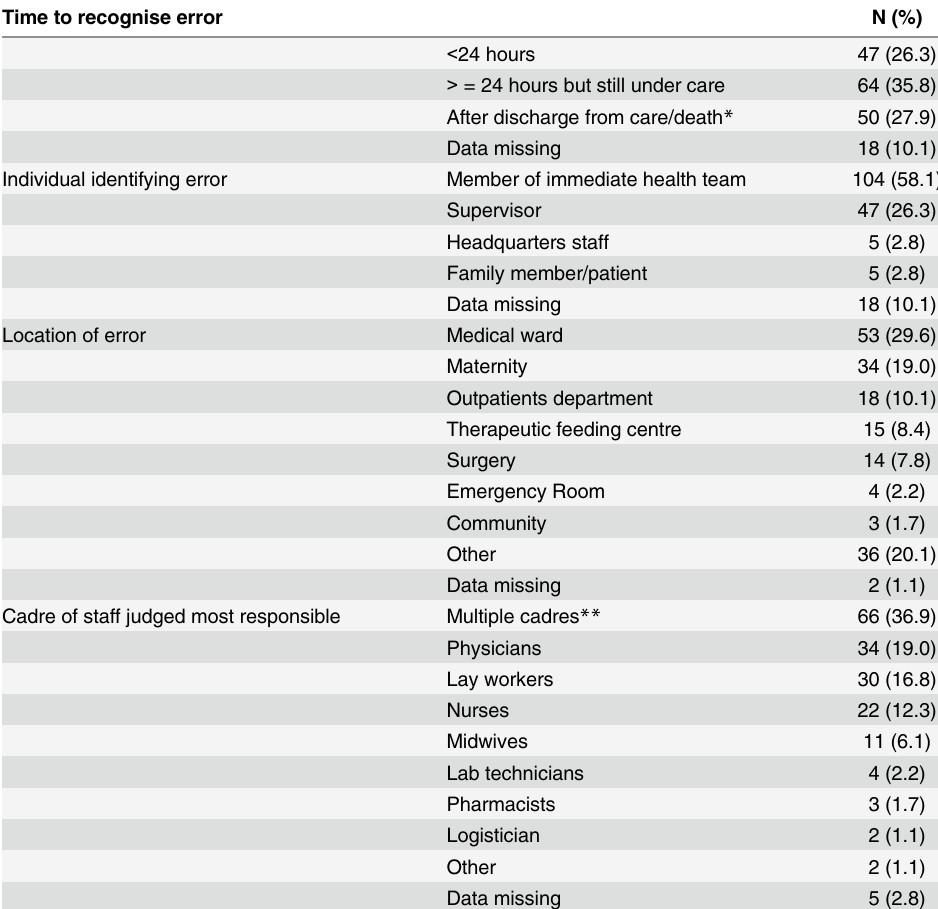
Table 1. Characteristics of Errors